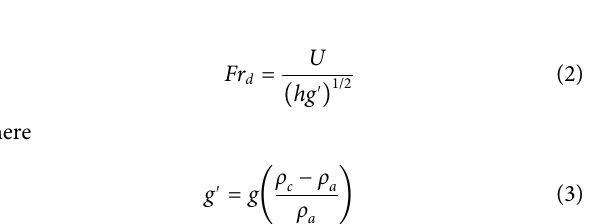
Frontiers in Earth Science |